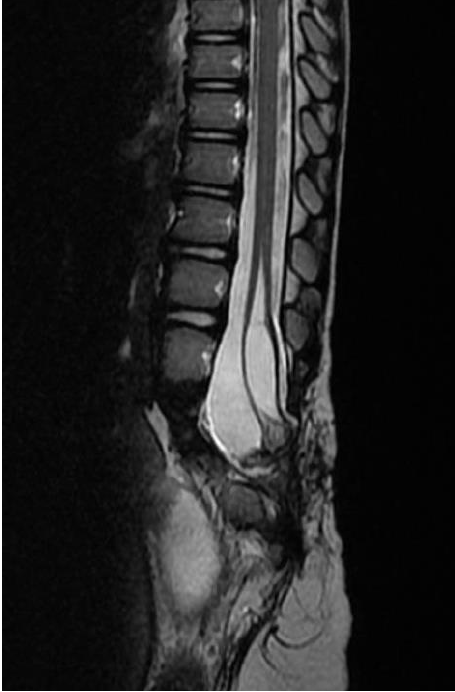
Figure 3. An intra-operative photo illustrates the split spinal cord within two dural sacs (SCM type II) prior to dural opening. The black arrow points to the spinal cord proximal to the bifurcation point. The stars points to the bifurcation points. The two white arrows point to the two cords distal to the bifurcation point.